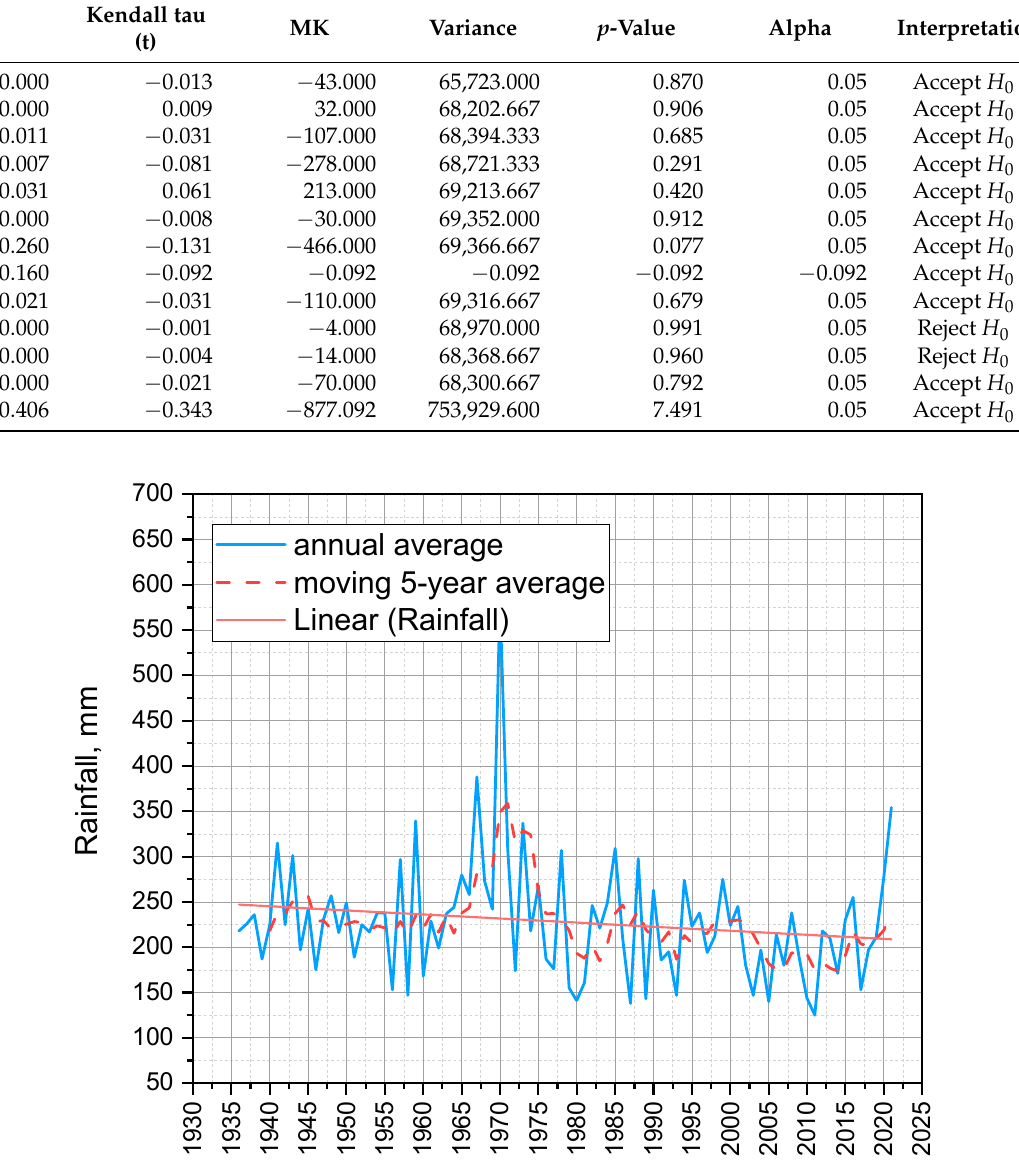
Data on average monthly precipitation covered the period from 1936 to 2021